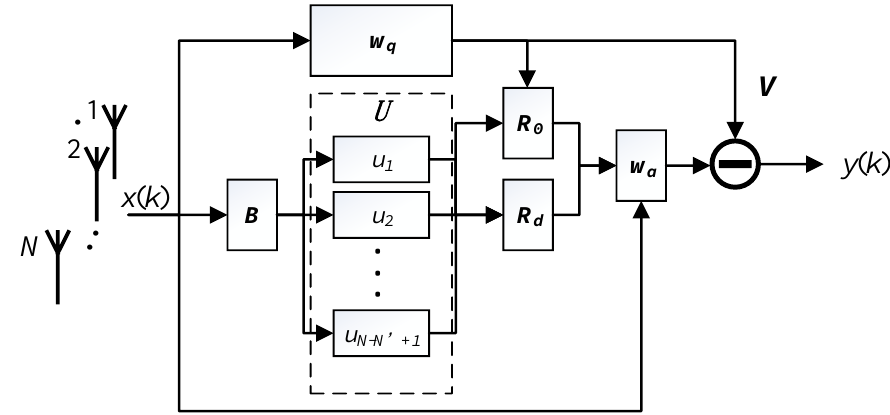
Figure 4. The framework of the VSSA-GSC.